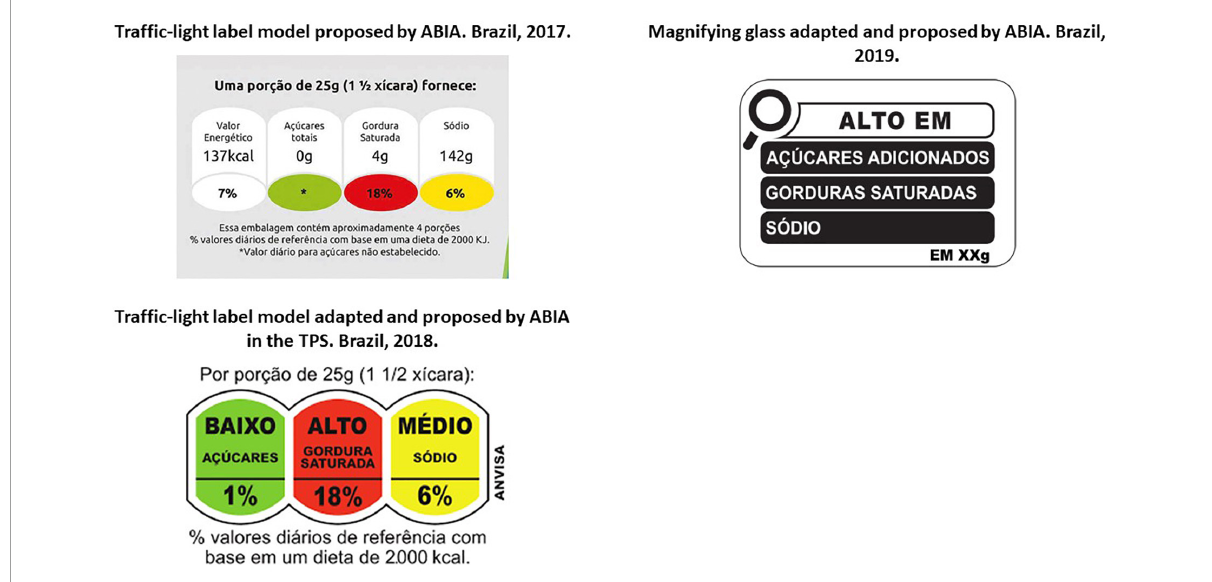
FIGURE1 Different FoPNL models proposed by ABIA during the regulatory process. (A) Traffic-light label model proposed by ABIA. Brazil. 2017. (B) Traffic-light label model adapted and proposed by ABIA in the TPS. Brazil. 2018. (C) Magnifying glass adapted and proposed by ABIA. Brazil, 2019. Sources: Anvisa and ABIA. ABIA, Brazilian Association of the Food Industry; TPS, Public Collection of Information.